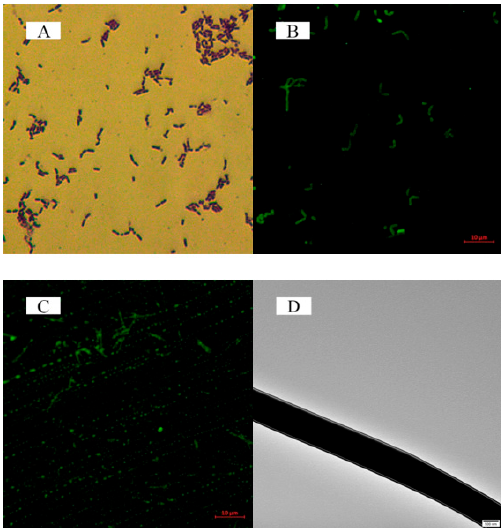
Figure 6. ( A ) Inverted optical microscope image of lactic acid bacteria, ( B ) Laser scanning confocal microscopy (LSCM) image of lactic acid bacteria, ( C ) LSCM image of coaxial electrospun nanofibers, and ( D ) Transmission electron microscopy (TEM) image of coaxial electrospun nanofibers.